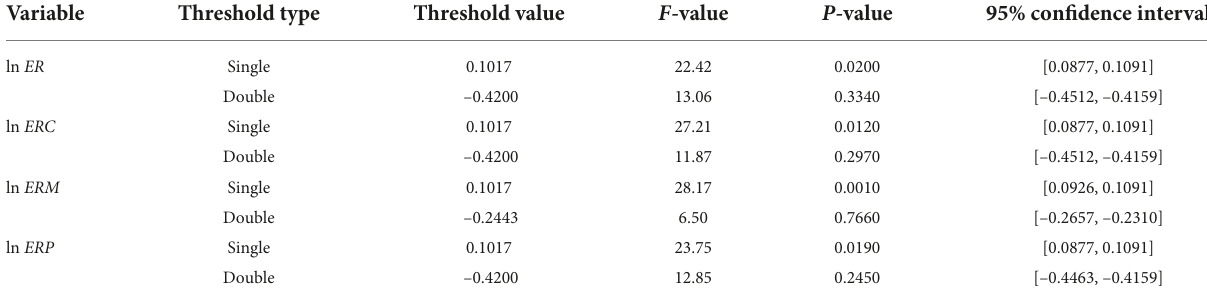
TABLE 7 Test of the threshold effect of fiscal decentralization.